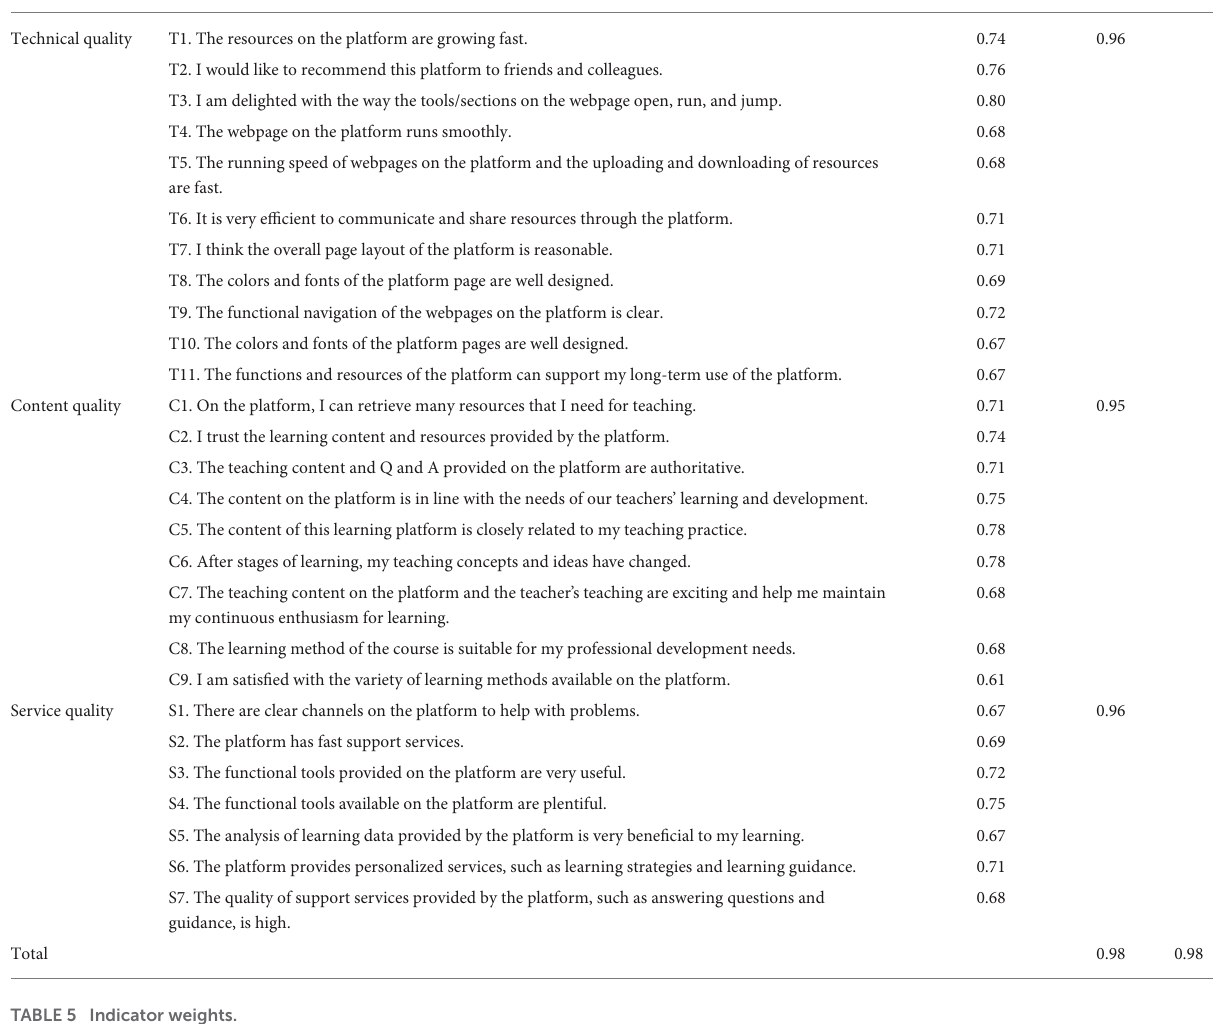
TABLE 4 Analysis of the final questionnaire’s validity and